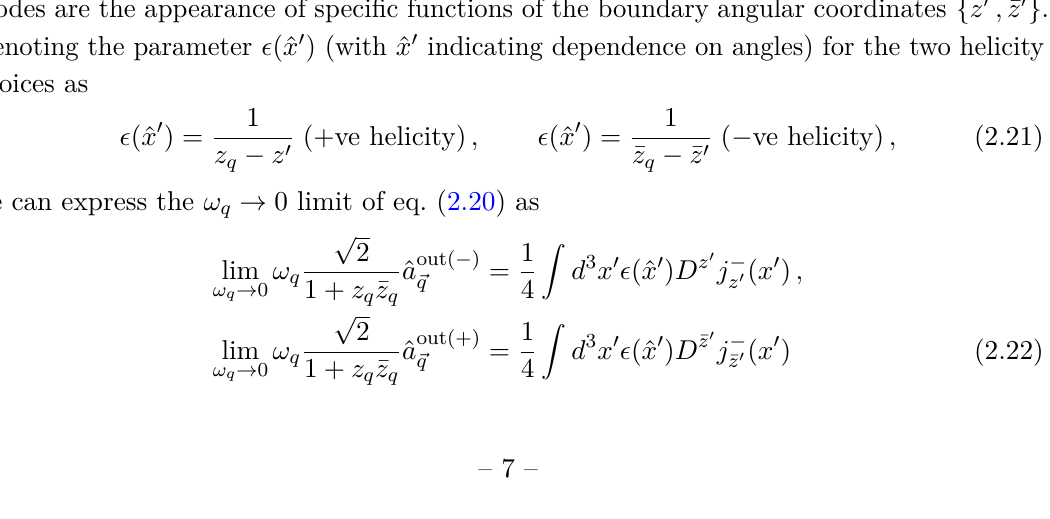
Figure 1 . The future (pink) and past (blue) null infinities of the central flat spacetime patch, I + and I − respectively, can be identified as the L → ∞ limits of boundary regions . Massless particles approaching the soft limit on the flat spacetime patch more closely τ 0 = ± π 2 approximate the τ 0 = ± π surfaces. As an example, we have drawn a soft particle trajectory (yellow). 2 The dashed line up to the boundary indicates the global trajectory outside the patch, but has no role in mapping the boundaries of AdS to those of the flat spacetime patch. Timelike infinities i ± on the flat spacetime patch are identified with the Euclidean caps ∂ M identified with τ ∈ {− π , π } 2 2